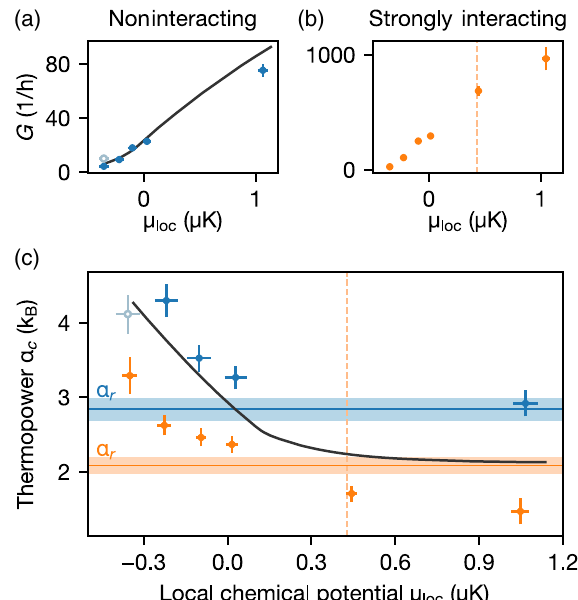
FIG. 3. Controlling thermopower with a gate potential. (a,b) Conductance G versus local chemical potential μ (a) noninteracting and (b) strongly interacting regimes. Separately measured values are indicated as dark points (Appendix B 3), and the light-blue open circle shows the fitted conductance corresponding to the dashed curve in Fig. 2(a). (c) Fitted thermo- power α without (blue points) and with strong (orange points) c interparticle interactions and the corresponding dilatation coef- ficients α of the reservoirs (horizontal lines). Shaded regions r indicate one standard deviationtoeachside.Solid black lines show an ab initio prediction based on Landauer theory in the absence of interactions (Appendix E). The vertical dashed line locates the superfluid transition inside the channel, while the reservoirs remain uncondensed (Appendix B 4). No measurement was taken ∼ 0 . 4 μ K in the noninteracting at μ loc